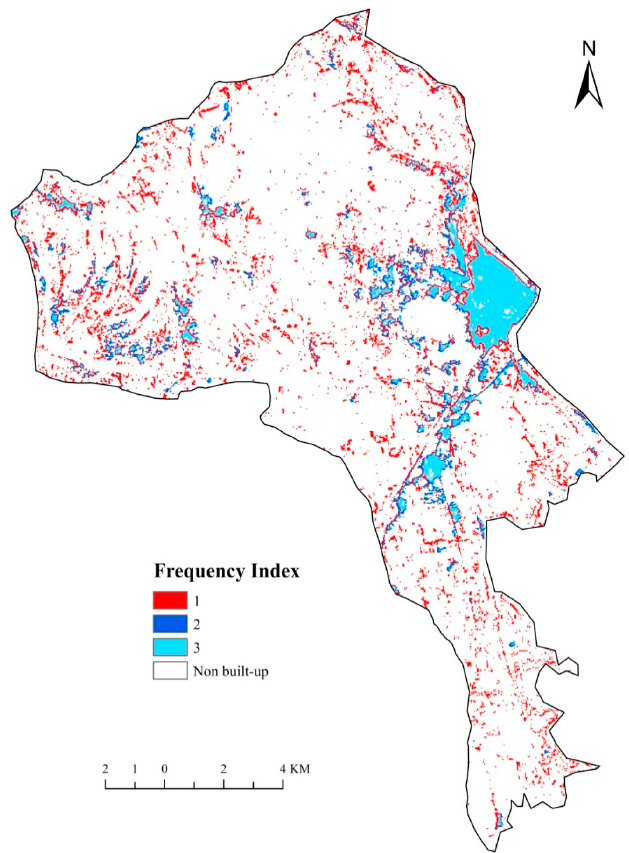
Figure 7. Frequency approach model to show the expanded built-up area over time.